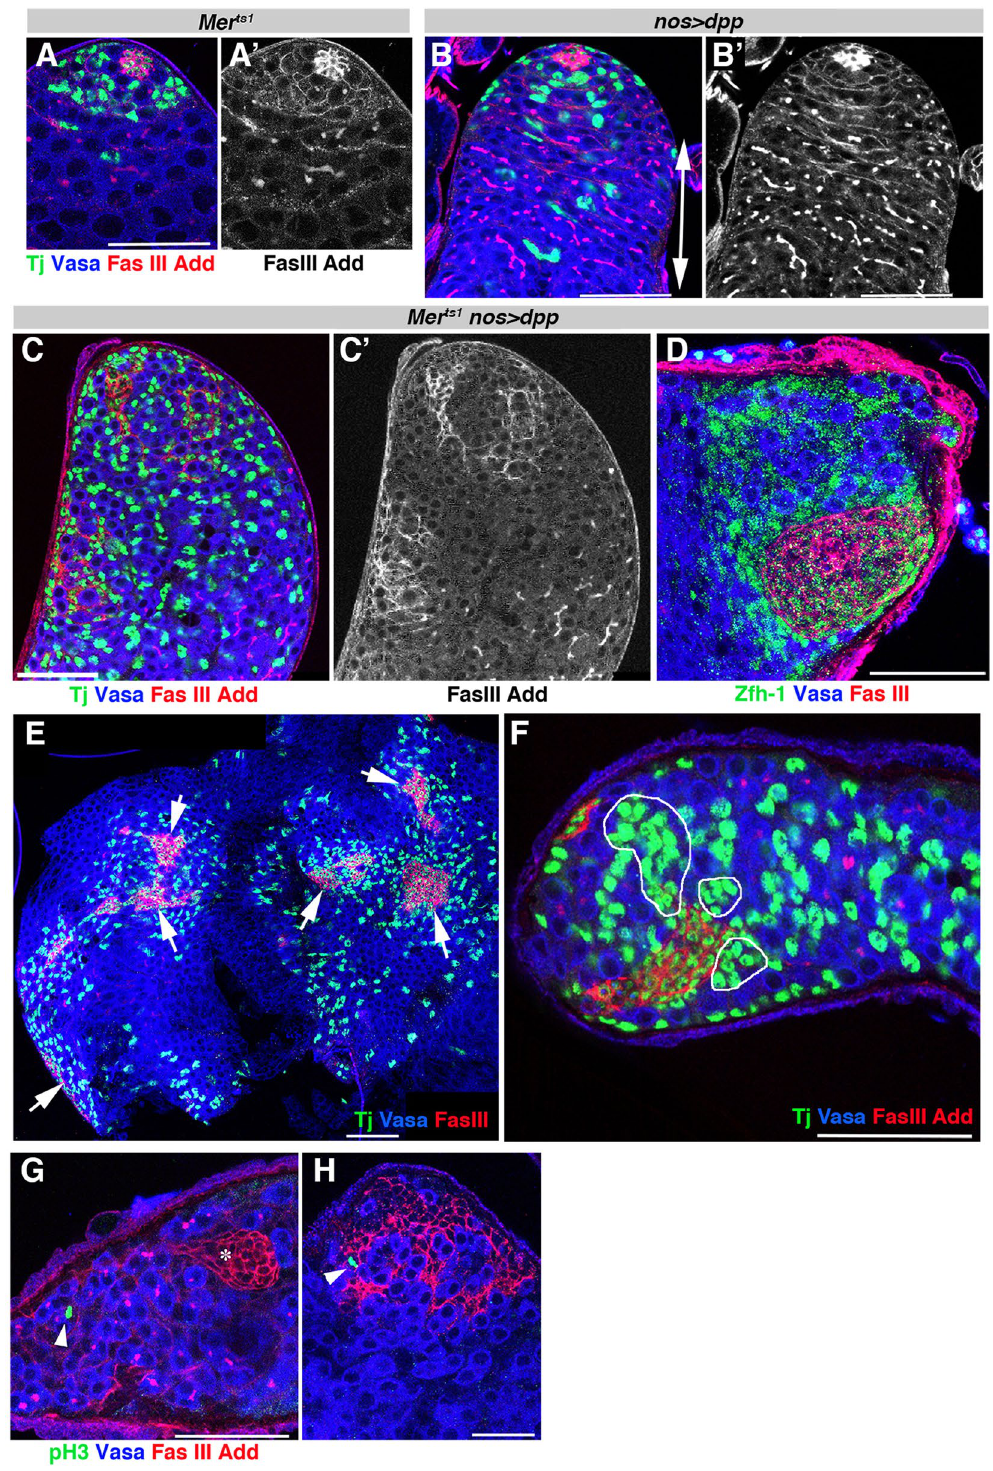
Figure 4. Ectopic expression of Dpp drives tumorous CySC/CC expansion in the Mer mutant. ( A – C ) The apical tip of the testis in Mer ts1 ( A ), nos > dpp ( B ), and Mer ts1 ; nos > dpp ( C ) stained for Tj (Green), Vasa (Blue), Add, and Fas III (Red). Bar, 50 µ m. ( D ) The apical tip of the testis from Mer ts 1 ; nos > dpp stained for Zfh-1 (Green), Vasa (Blue), and Fas III (Red). ( E ) The apical tip of the testis from Mer ts1 ; nos > dpp stained for Tj (Green), Vasa (Blue), and Fas III (Red). Expansion of hub cells are shown by arrows. ( F ) The apical tip of the testis from Mer ts1 ; nos > dpp stained for Tj (Green), Vasa (Blue), and Fas III (Red). Clusters of Tj + CCs are indicated by white circles. ( G and H ) Examples of mitotic somatic cells [positive for phosphorylated histone H3 (pH3)] away from the hub ( G ) and within the expanded hub-like structure ( H ) in a Mer ts1 ; nos > dpp testis. Hub ( *